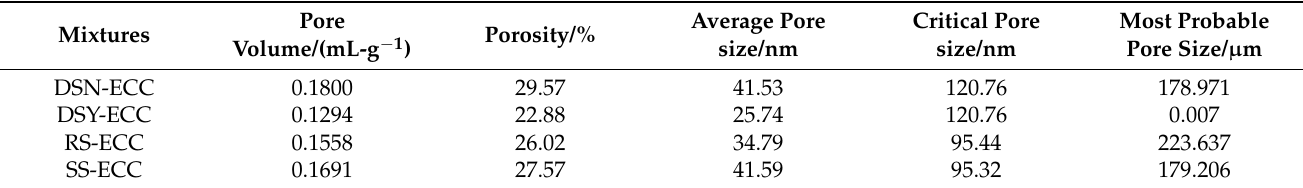
Table 6. Characteristic parameters of pore structure under different fine aggregate.